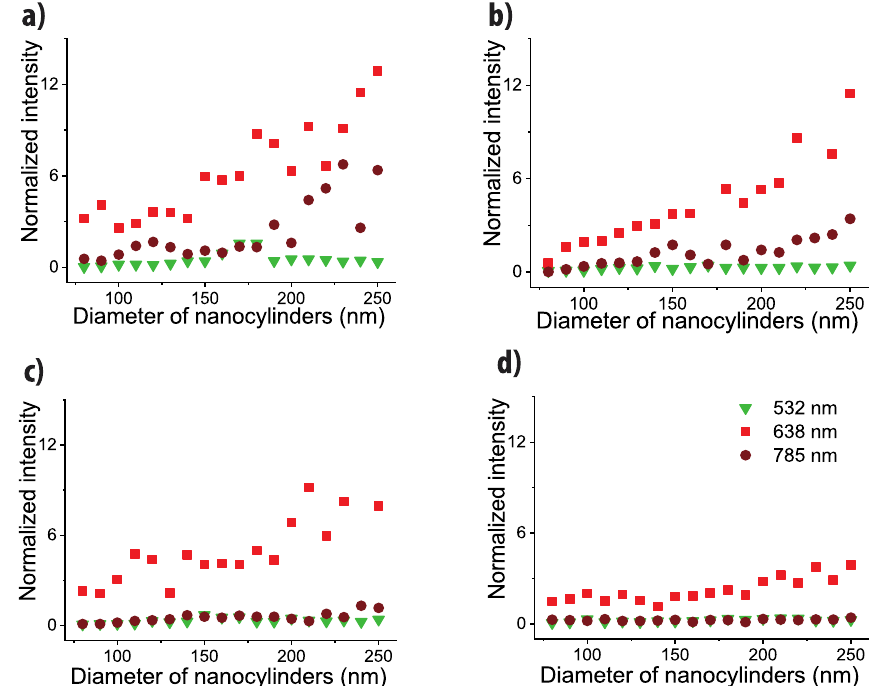
Figure 6. Evolution of the SERS intensities of the band located at 1580 cm −1 depending on the nanocylinder diameter and for the four film thicknesses: ( a ) 20, ( b ) 30, ( c ) 40, and ( d ) 50 nm. The SERS intensities have been normalized by the silicon Raman signal. Green triangles: excitation wavelength of 532 nm; Red squares: excitation wavelength of 638 nm; Brown circles: excitation wavelength of 785 nm.